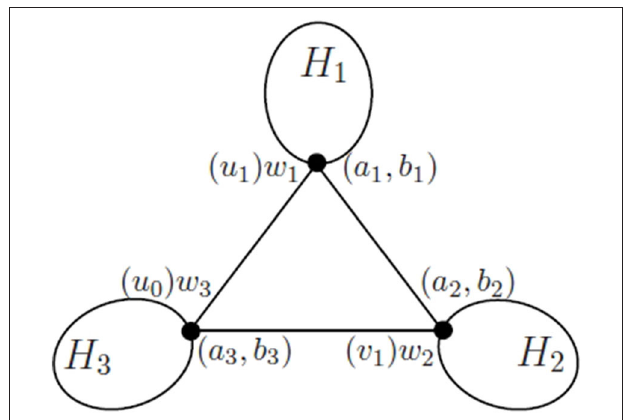
FIGURE 4 | Network G t .